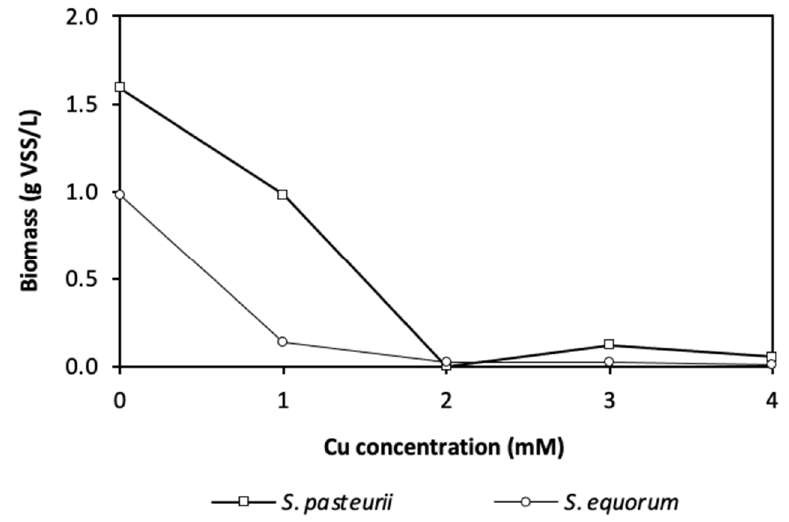
Figure 6. Observed biomass growth of S. pasteurii and S. equorum observed after 72 h cultivation, at different copper concentrations.